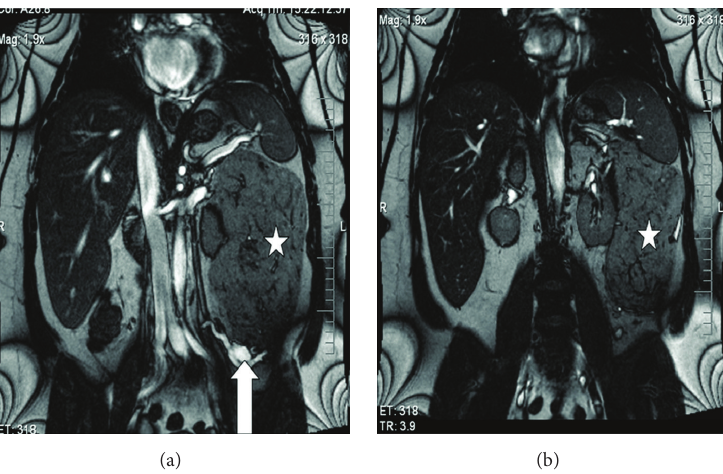
Figure2:Abdominalmagneticresonanceimagingdemonstratingalargefattyencapsulatedmass(whiteasterisk)measuring19.3 cm × 13.5 cm × 10.7 cm with prominent vascularity (white arrows). The anatomic relationship between the mass and the left kidney can be well seen in Figure 2(b). Reproduced from